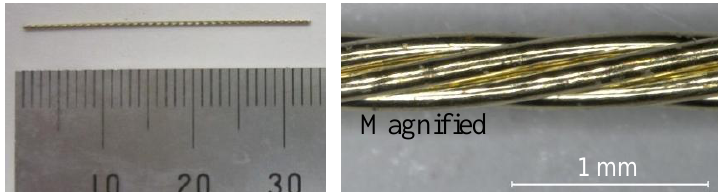
Figure 2. Steel code (SC)